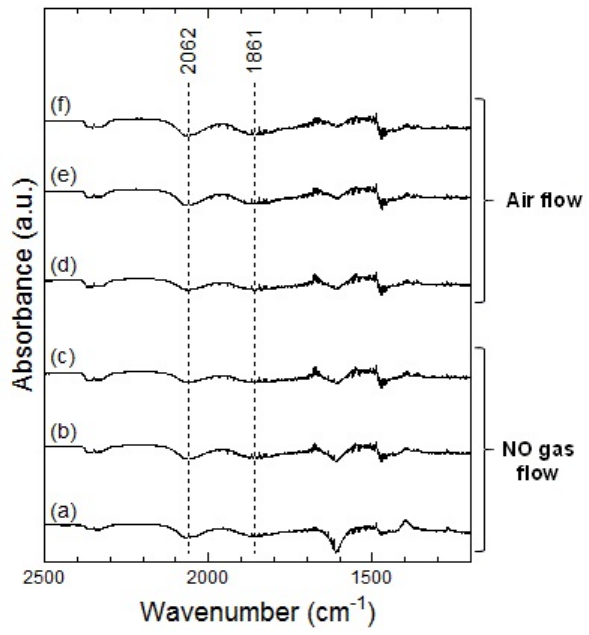
powder at 100 °C. The powders were exposed to 1 ppm Figure 9. DRIFT spectra of WO 3 of NO in air for ( a ) 2 min, ( b ) 20 min, and ( c ) 50 min. After NO exposure, the